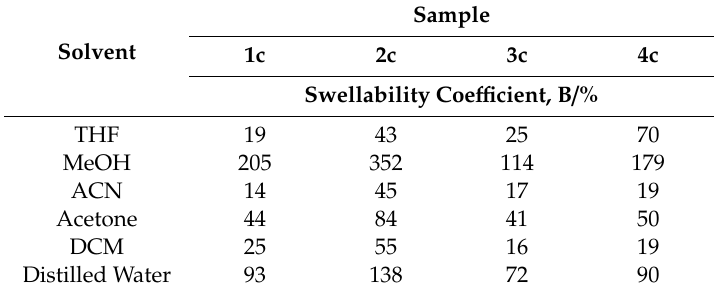
Table 7. Swelling properties.